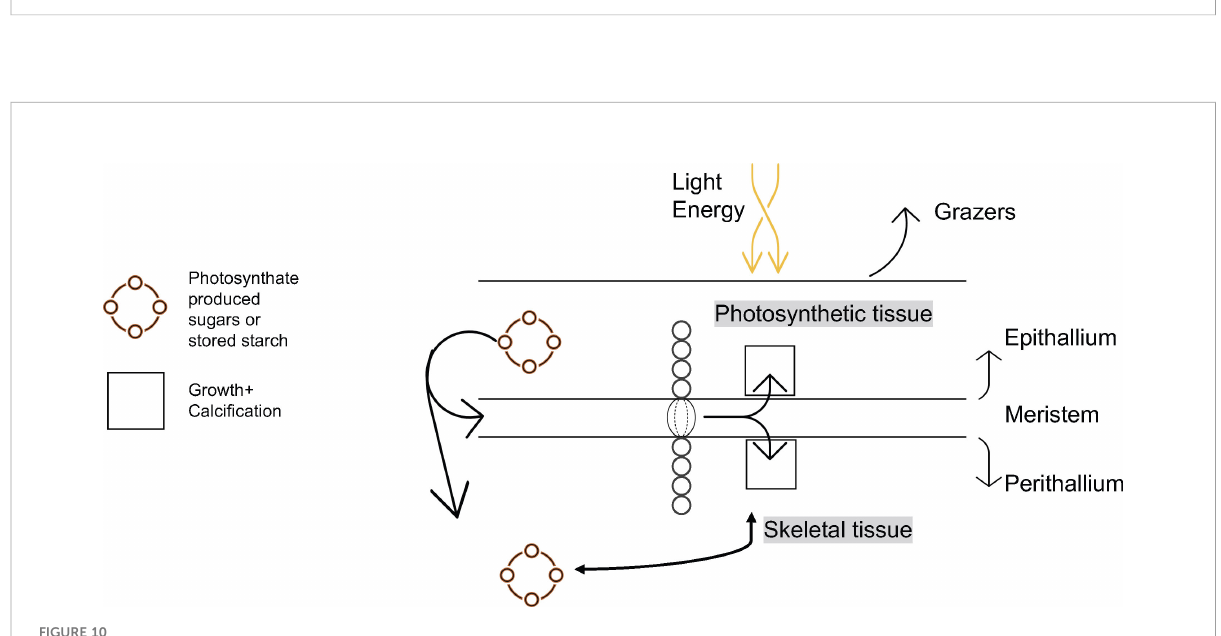
FIGURE 10 Schematic representation of algal growth and calci fi